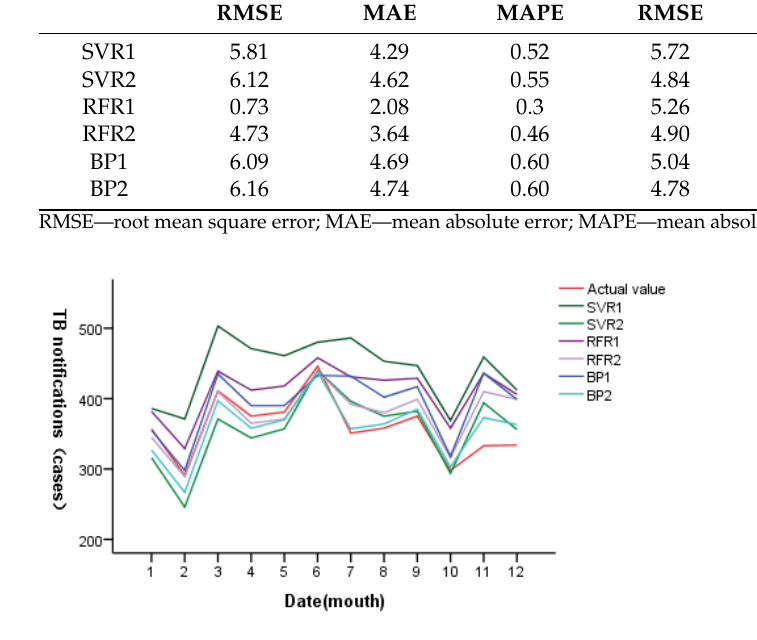
Table 7. Comparison of SVR, RFR and BP neural network prediction models. Models